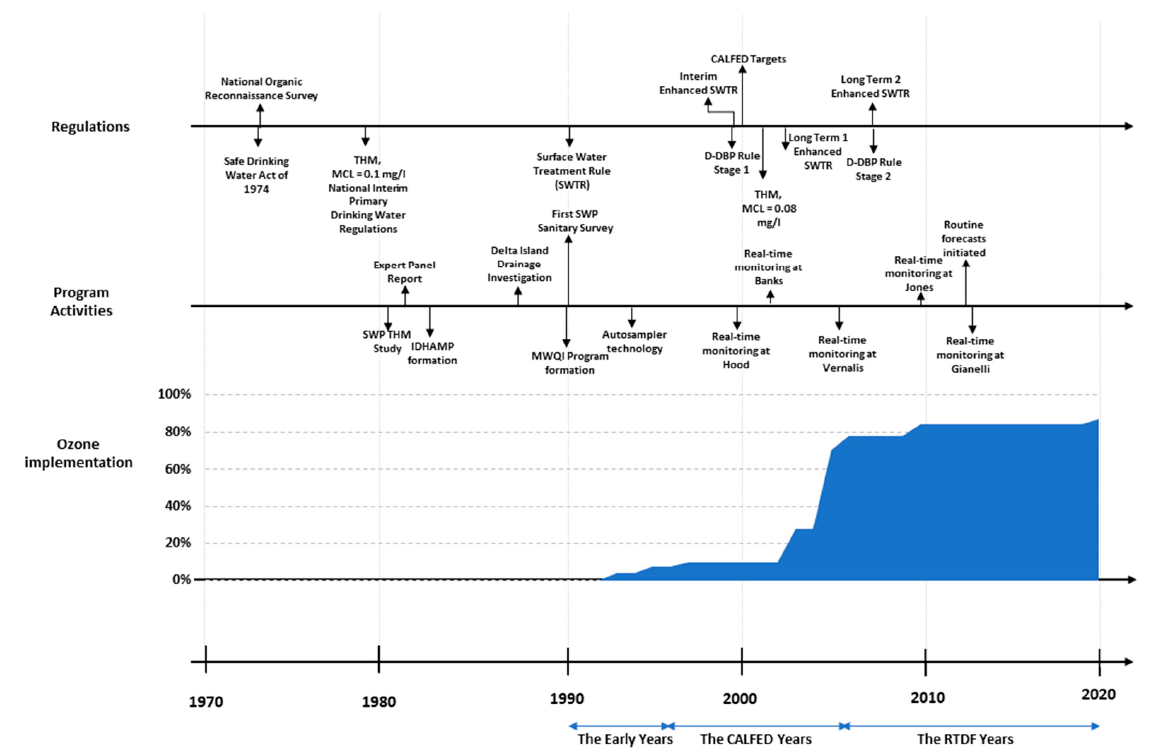
Figure 2. Timeline showing the evolution of drinking water regulations, MWQI program activities, and ozone implementation by participating MWQI water contractors.